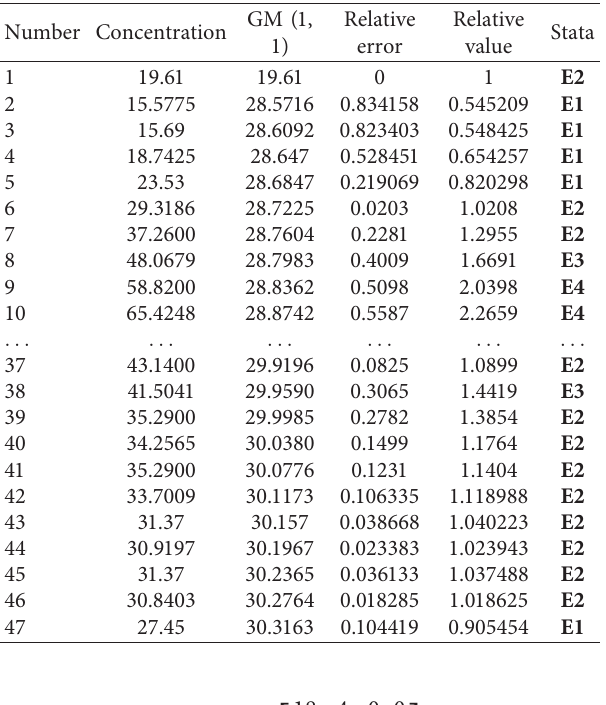
Table 4: State partition table. Table 3: Prediction of mine dust concentration by the GM (1, 1)